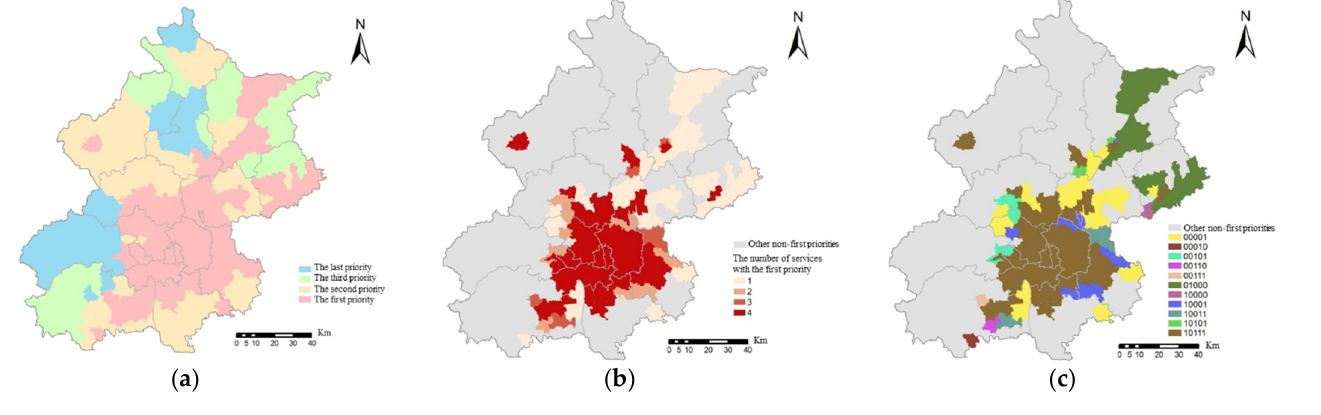
Figure 7. Subdistrict-scale ECC improvement priority zones ( a ) Level A; ( b ) Level B; ( c ) Level C.